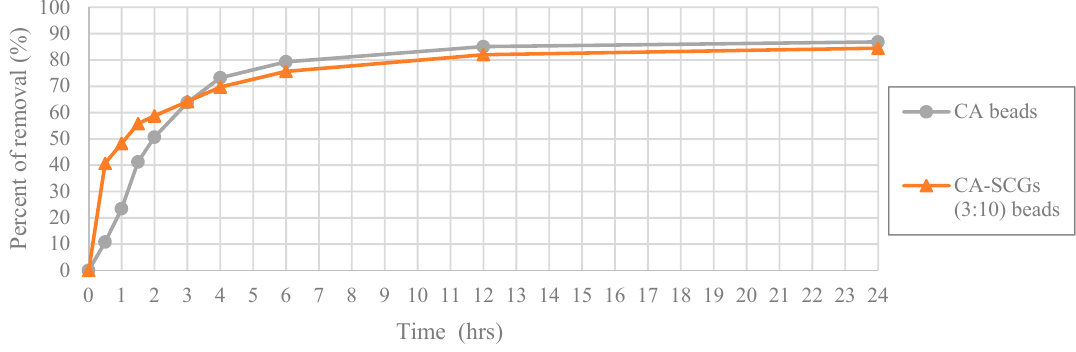
Figure 14. Plot of Percent of removal vs Time at initial concentration of 100 ppm of Cu 2+ , CA and CA-SCGs (3:10) beads.